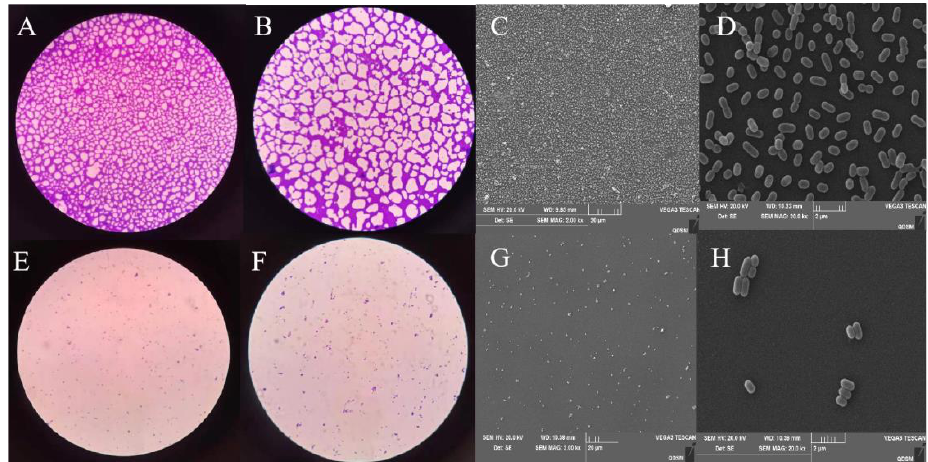
Figure 7 . Inhibitory effect of plantaricin Q7 on the formation of L. monocytogenes biofilm. Optical